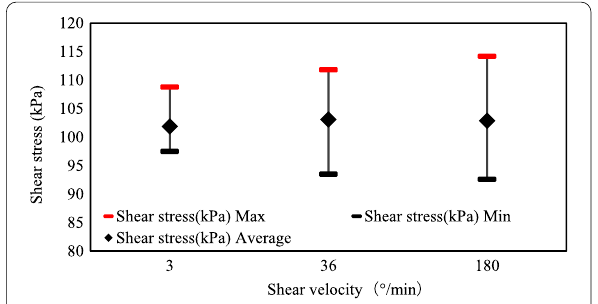
Fig. 4 Relationship between the average, maximum, and minimum residual shear strains and the shear velocity